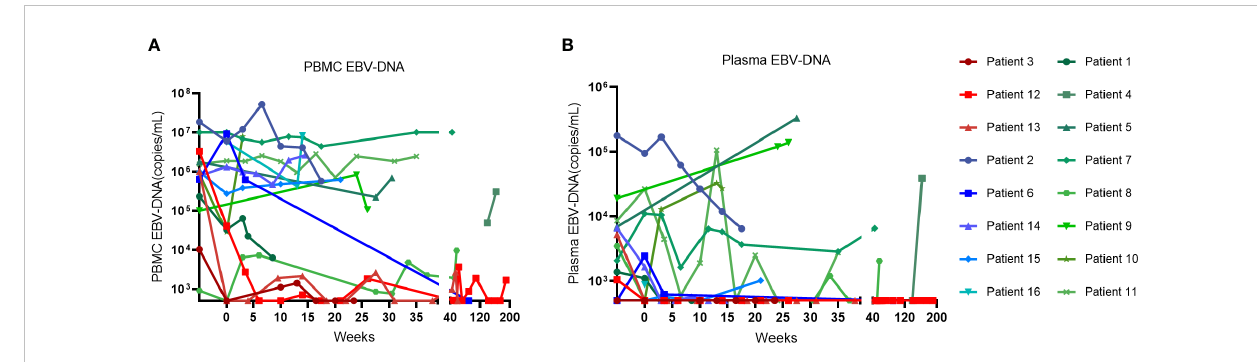
FIGURE 2 The change of EBV-DNA copy numbers after PD-1 inhibitor infusions in patients. (A) EBV-DNA copy numbers in the peripheral blood of patients. (B) EBV-DNA copy numbers in the plasma of